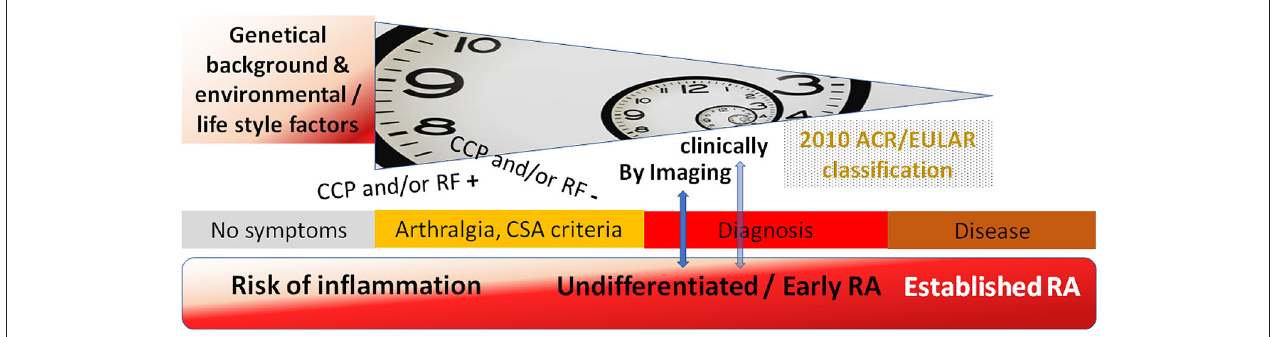
FIGURE 2 | Overview of study time points in the at-risk programs, following up antibody (CCP and/or RF) positive and negative individuals until occurrence of arthritis detected by imaging (KI) or clinically (MUV, UKER, LUMC, UNEW), potentially with overlap to classification as RA according to the 2010 ACR/EULAR criteria.